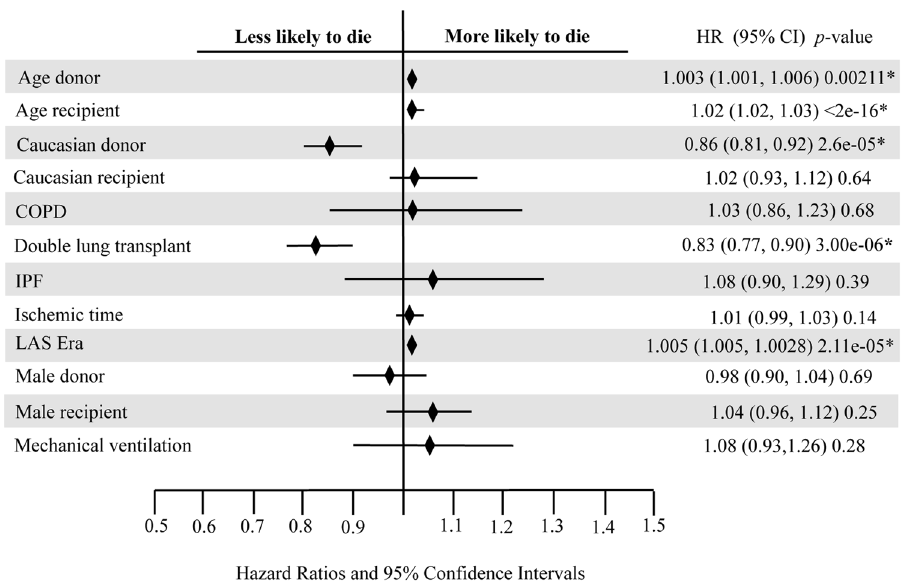
Figure 2. Forest plot representing independent factors associated with mortality in patients with sarcoidosis who undergone lung